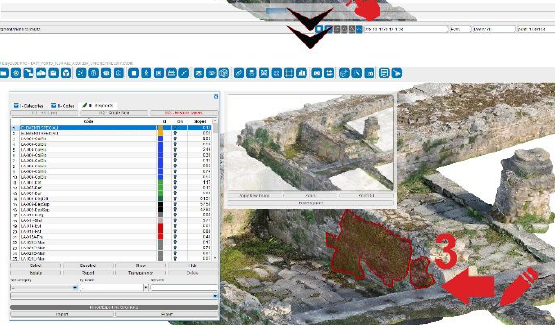
Figure 5. EasyCUBE PRO user interface for inserting/modifying segmentation codes